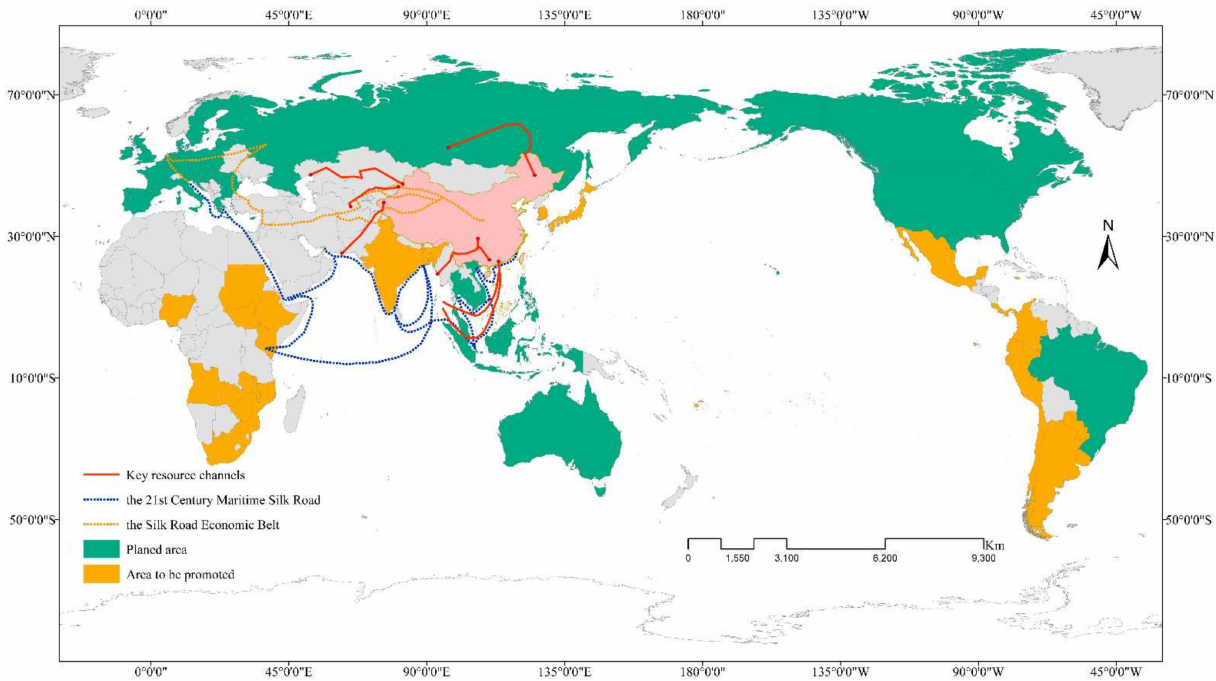
Figure 6. Global development status of